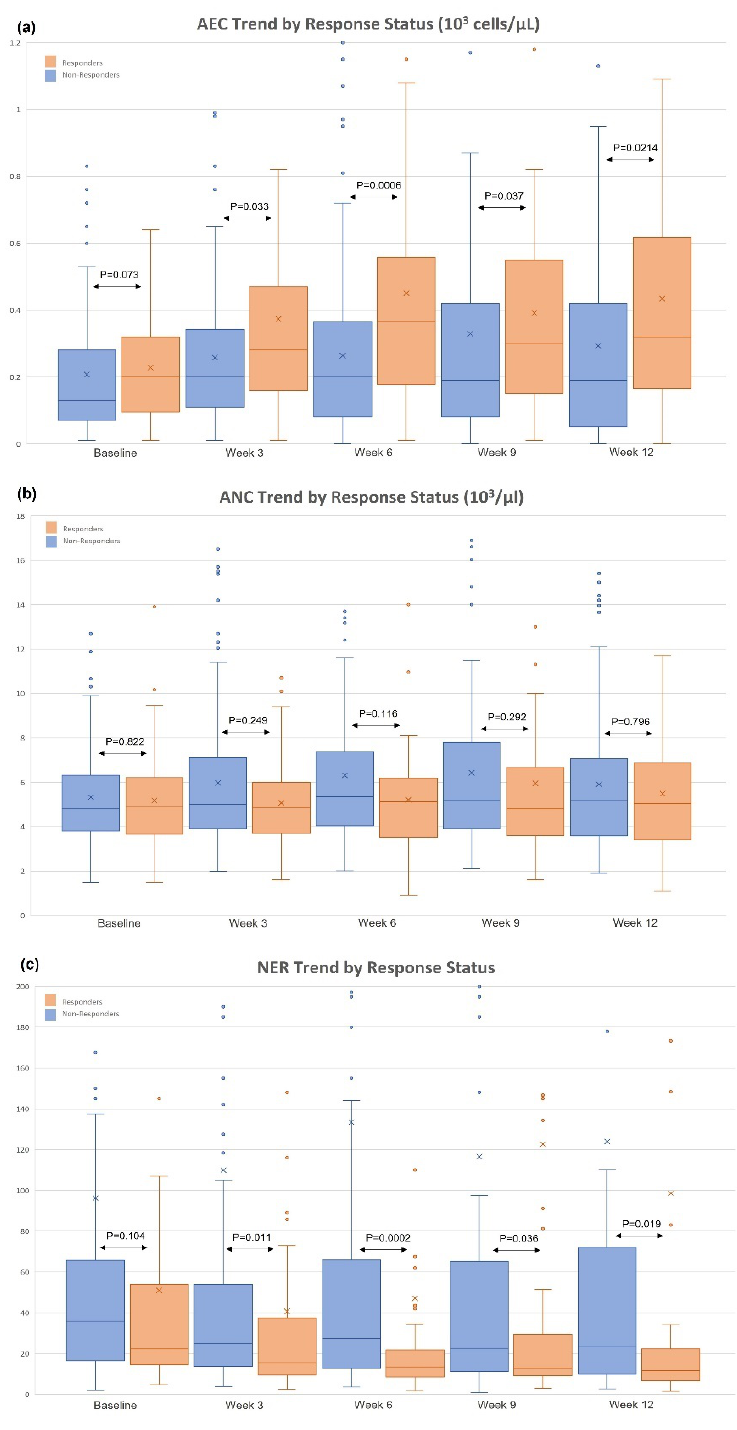
Figure 1. Trend of AEC/ANC/NER by response status. There were 150 ipilimumab/nivolumab-treated patients with mRCC included in the final study population (Table 1). The median age was 62 (interquartile range: 53–70), 74% were male, and 80% were White. The majority of patients had clear cell histology (78%); 22% were IMDC favorable risk, 63% were intermediate risk, and 15% were poor risk. There were 104 (69%) patients who had prior nephrectomy, and 49 (33%) patients who had prior systemic therapy. The median follow-up time was 11.6